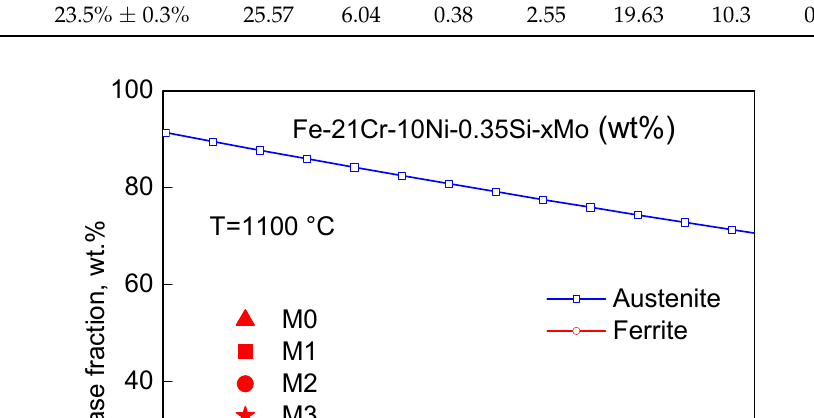
Figure 2. Variation of phase fraction with Mo content for Fe-21Cr-10Ni-0.35Si-xMo alloy, calculated using JMatPro. Table 1. The ferrite content and compositions in the two phases of CDSS.